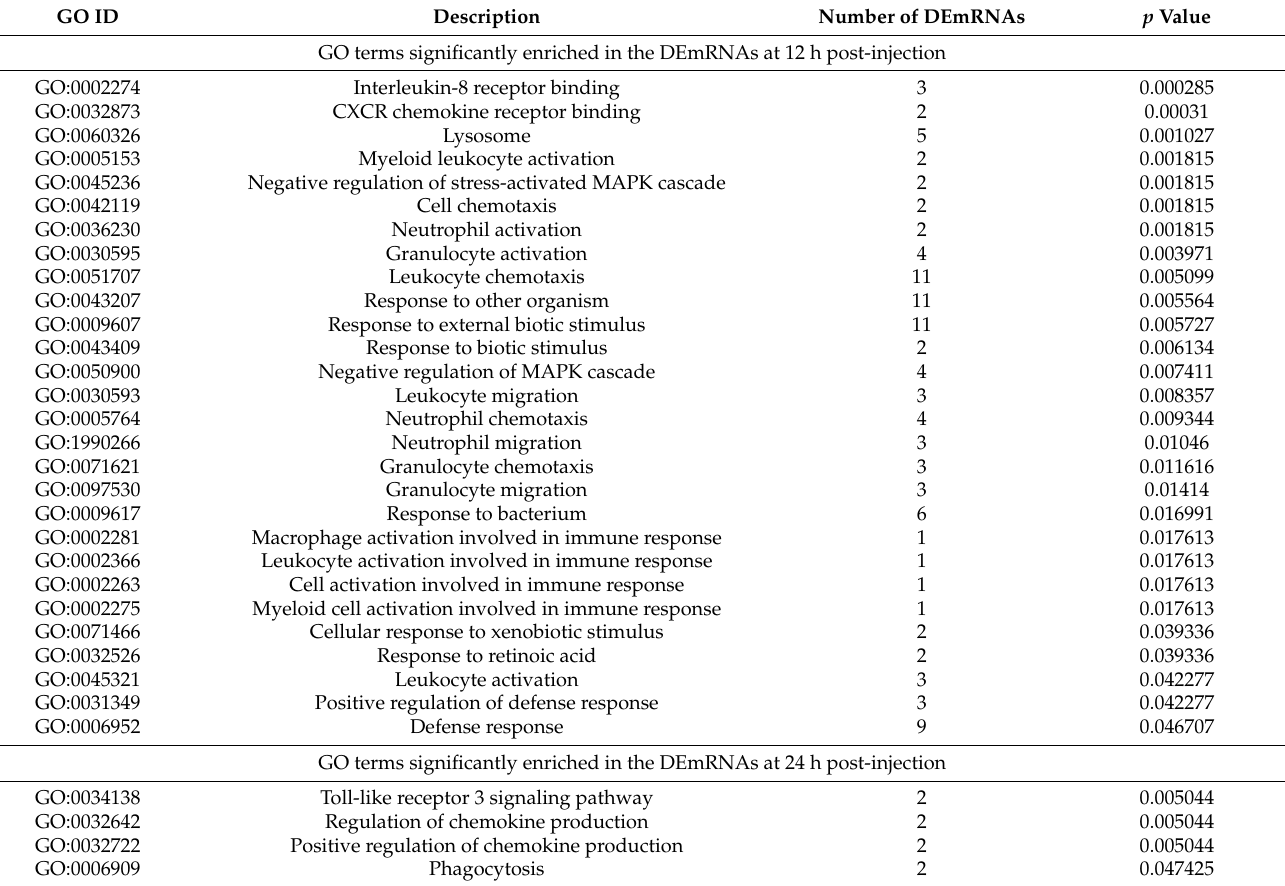
Table 3. Immunity-related GO terms significantly enriched in the